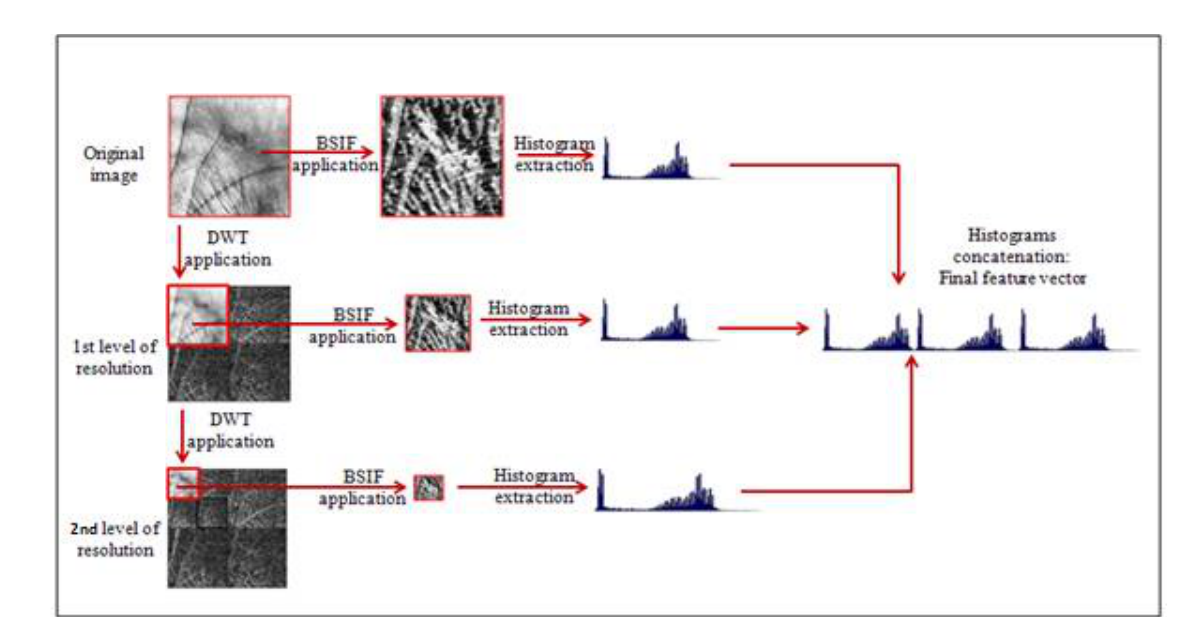
Figure 4. Graphical flowchart of the proposed feature extraction approach.